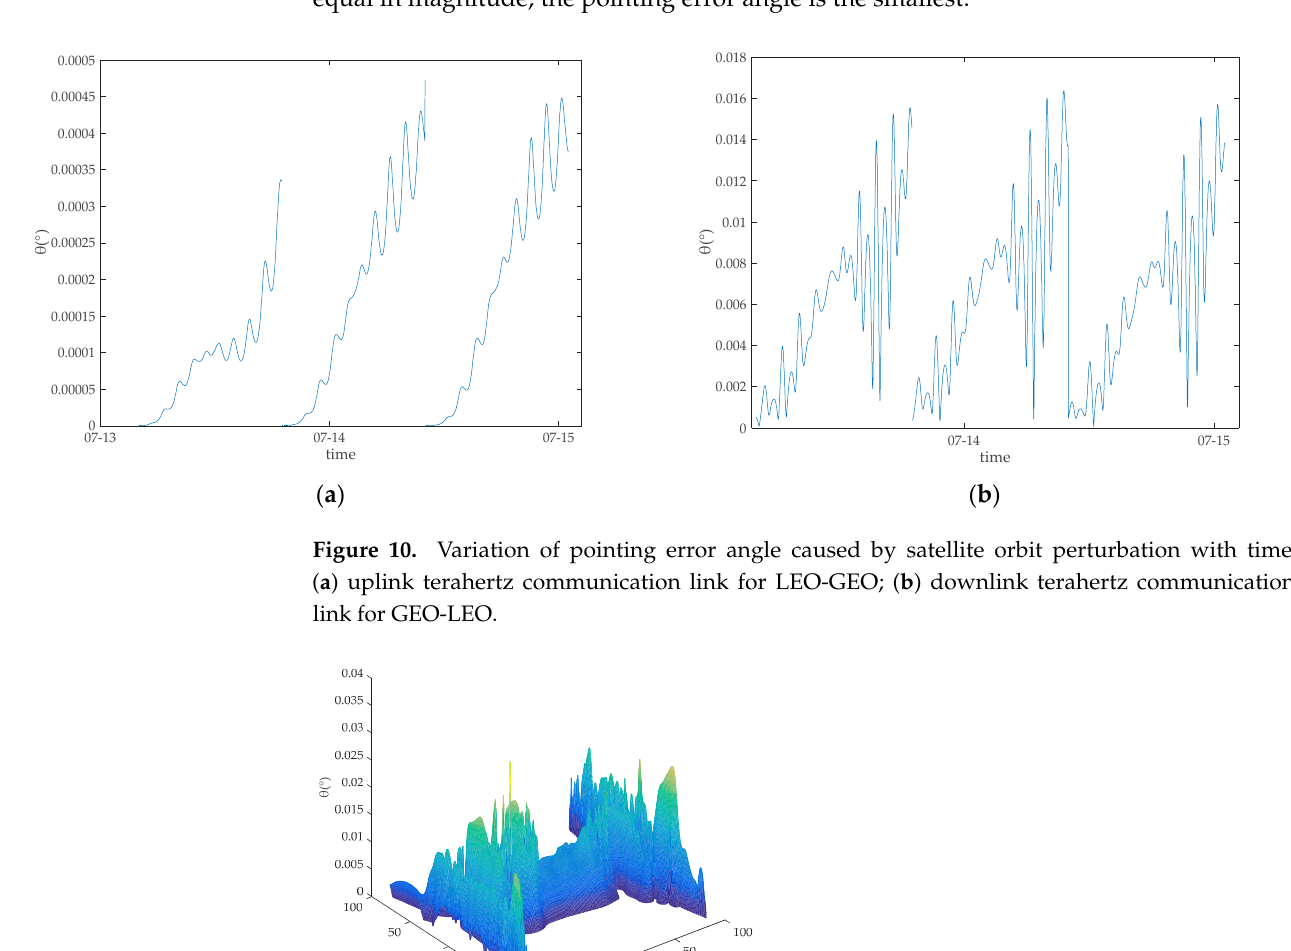
13 of 18 Figure 9. Schematic diagram of stk simulation scene. The low-orbit satellites and geostationary-orbit satellites will be affected by various perturbation forces during operation, resulting in orbital deviations. If the perturbation forces are allowed to act on the satellites, the satellite orbits will change dramatically, re- sulting in huge pointing errors. Therefore, when the satellite passes through the ground station, the ground station will send an orbit control command to the satellite to correct the error of the satellite deviating from the orbit, so that it can return to the predetermined orbit and effectively control the pointing error. In this paper, it is assumed that every time